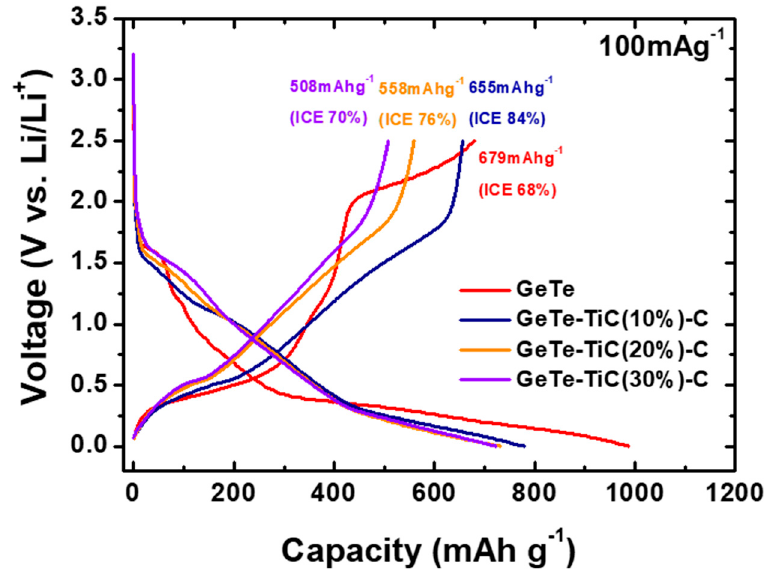
Figure 4. Initial voltage profiles of GeTe and GeTe-TiC-C (TiC: 10, 20 and 30 wt %) electrodes at a constant current density of 100 mA g − 1 .